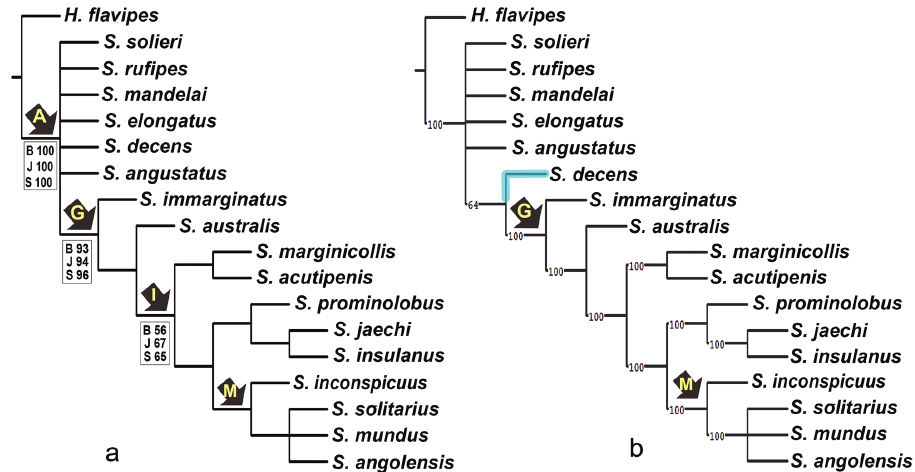
Figure 24. Results of the phylogenetic analysis based on 52 discrete morphological characters. a strict consensus tree. Bootstrap (B), Jackknife (J) and Symmetric (S) support values over 50% are mentioned above the corresponding branches b majority-rule consensus tree of 36 most parsimonious trees (length 110). Numbers on the branches indicate majority rule support for nodes. Arrows with capital letters indicate selected